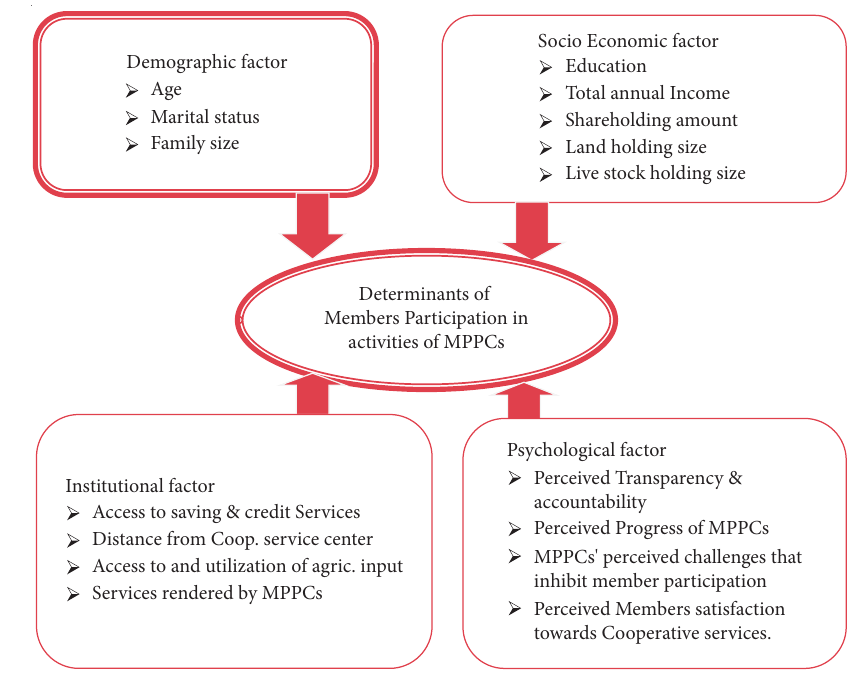
Figure 1: Conceptual framework (source: Own Design Based on the Reviewed Literature (2019)).